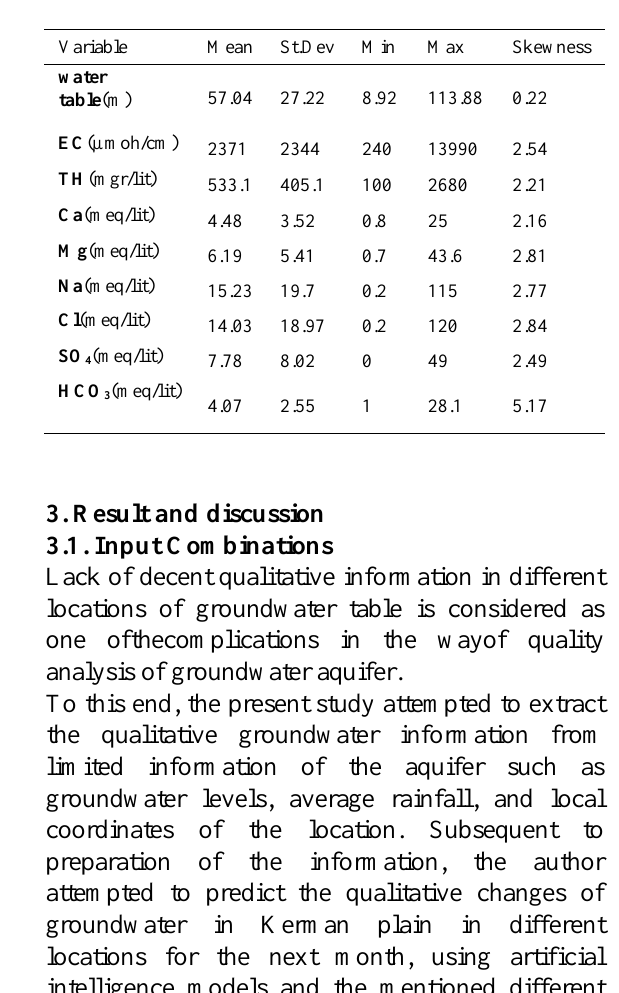
Table 1.Statistical parameters of